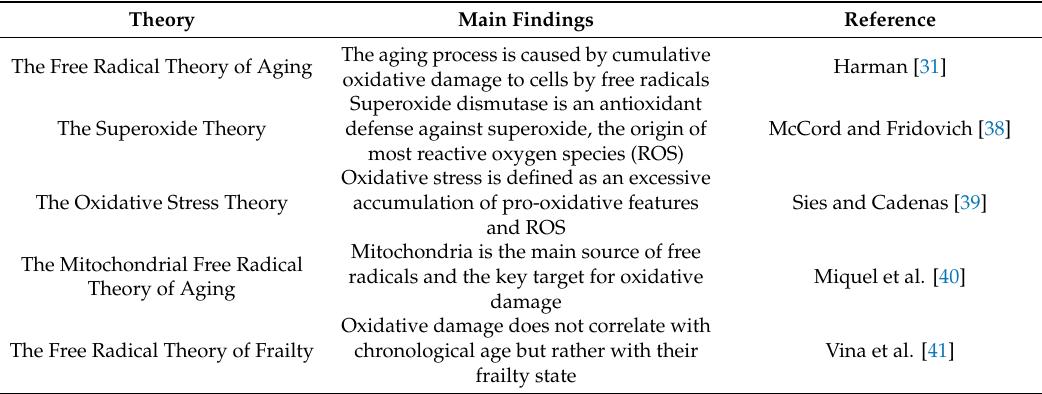
Table 1. The Main Mitochondrial Theories of